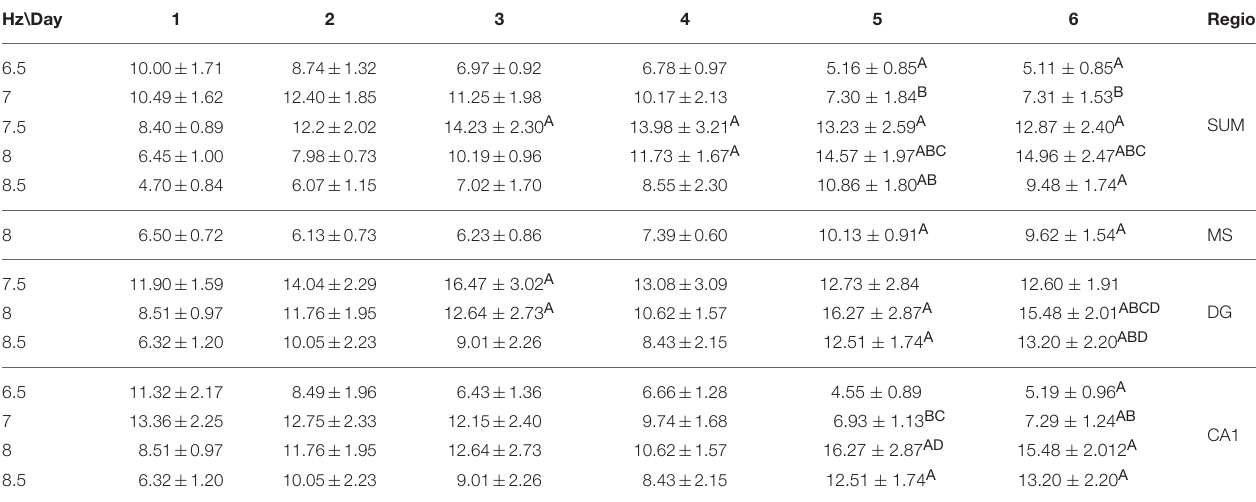
TABLE 1 | Comparison between training days of the relative power recorded during the searching for the platform in the Morris water maze task in the CTR group.